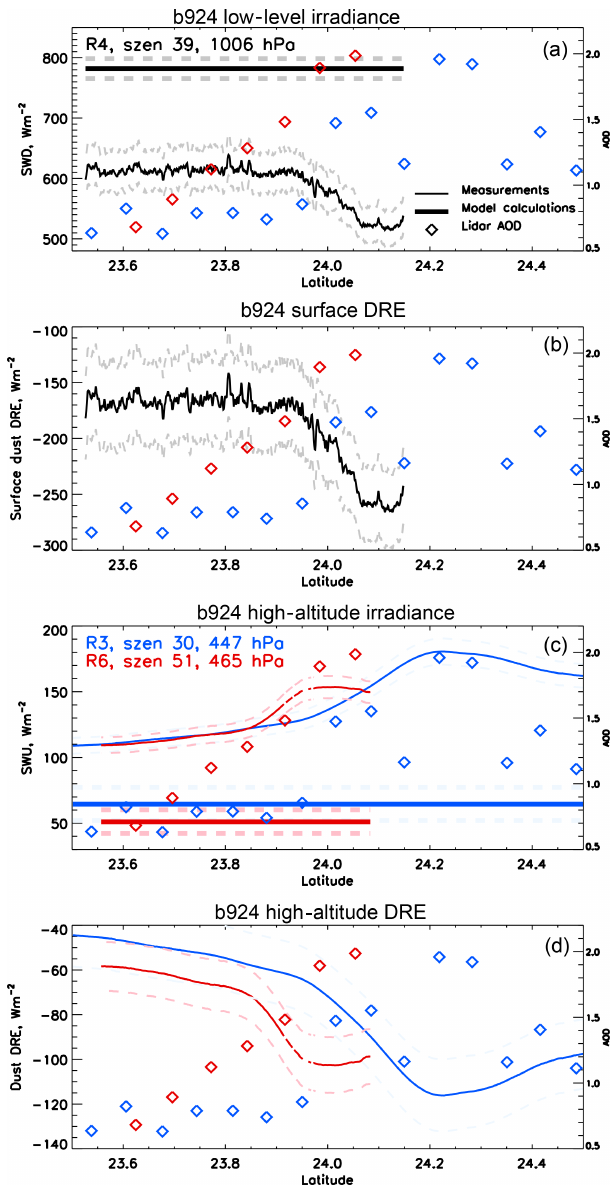
Figure 5. Solar irradiance and instantaneous direct radiative effect of dust ahead of and within the dust front during flight B924. Ob- servations are the thin lines, model clear sky calculations are the bold lines, uncertainties are displayed through dashed lines and li- dar AODs are indicated with diamonds. (a) Low-level (run 4, 30m) measured and modelled shortwave downwelling irradiance; (b) sur- face direct radiative effect on the shortwave downwelling irradi- ance; (c) high-altitude shortwave upwelling irradiance for two air- craft legs (run 3, blue; and run 6, red); (d) high-altitude (TOA) direct radiative effect on the shortwave upwelling irradiance for runs 3 and